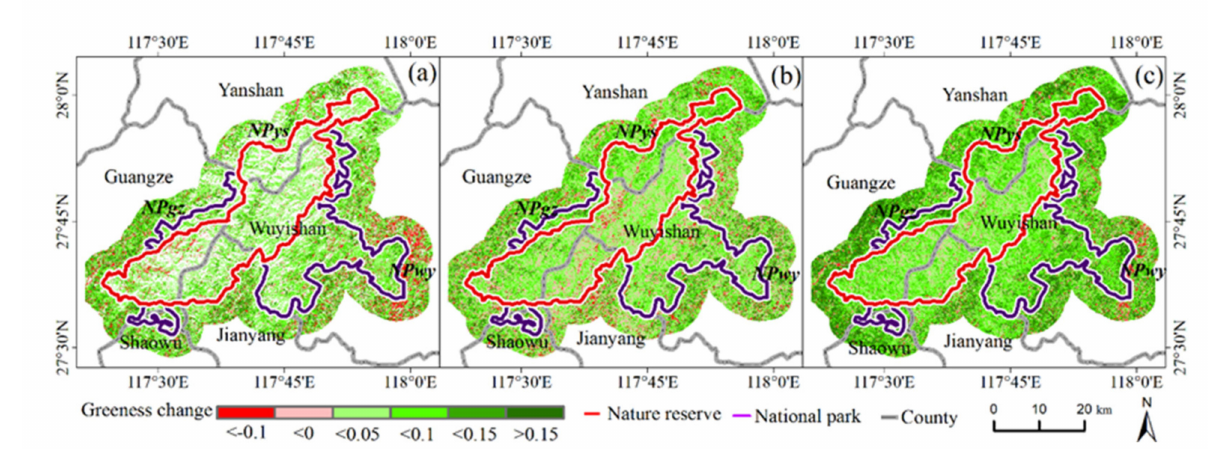
Figure 7. EVI changes in the study area during 1986–2020. ( a ) abrupt EVI change (A EVI ); ( b ) gradual EVI change (G EVI ); ( c ) total EVI change (T EVI ).